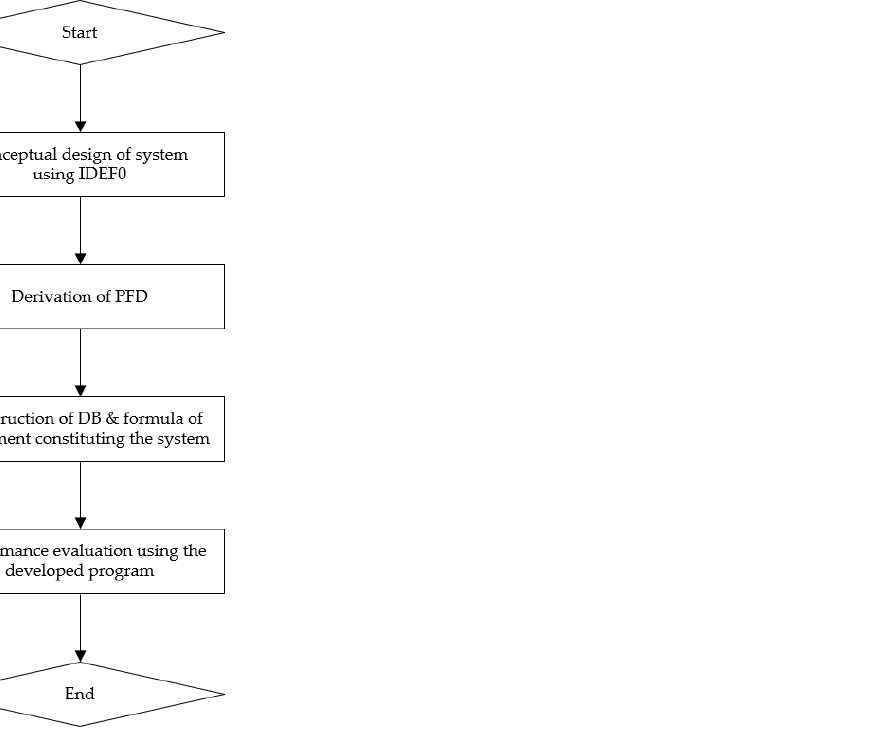
Figure 9. Conceptual design process based on reliability assessment of secondary energy conversion system.